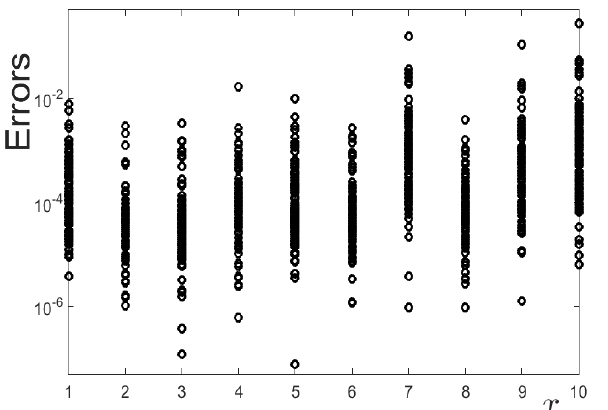
Figure 7. Errors of the computed degradations, Error x , as obtained by repeating the computations displayed in Table 5 one hundred times, with randomly chosen exact degradations and the initial conditions for the adapted Newton